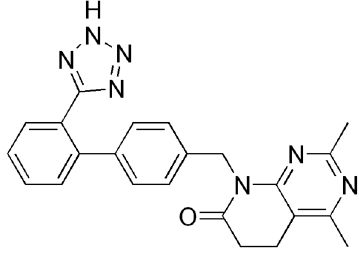
Figure 21. Tasosartan ( 65 ) .